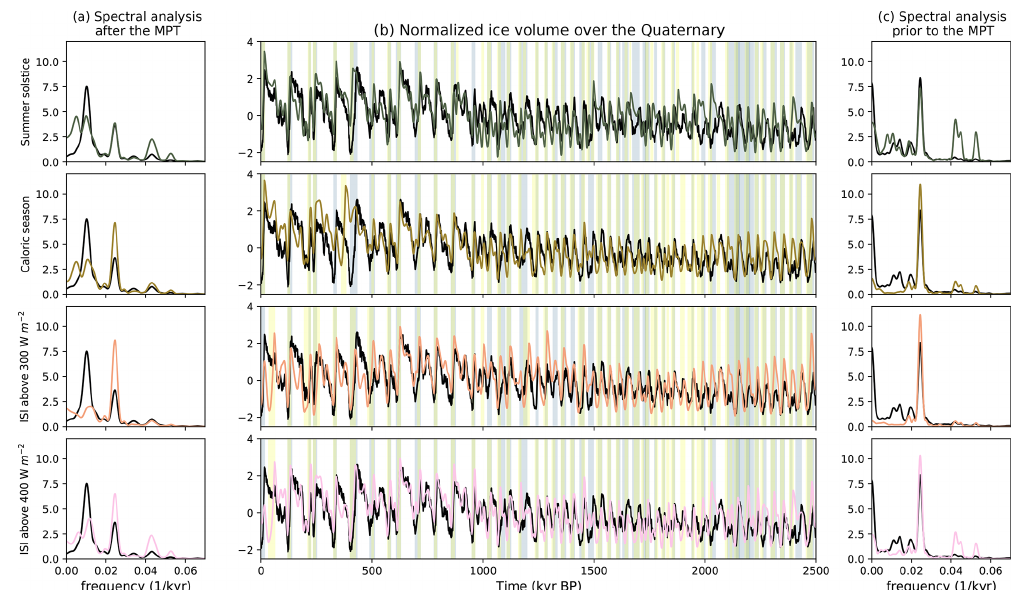
Figure 4. Best model fit over the whole Quaternary and corresponding spectral analysis. (b) presents the best fit of the model for the different summer insolation used as input, compared to the data. The results for the summer solstice insolation, caloric season, ISI above 300 and ISI above 400Wm − 2 are displayed. The data (normalized LR04 curve) are in black. The blue shading presents deglaciation periods in the data and the yellow shading deglaciation periods in the model. This results in a green shading when deglaciations are seen in the model and data at the same time. (a) presents the spectral analysis of the best fit solution over the last 1 million years. (c) presents the spectral analysis over the older part of the Quaternary (before